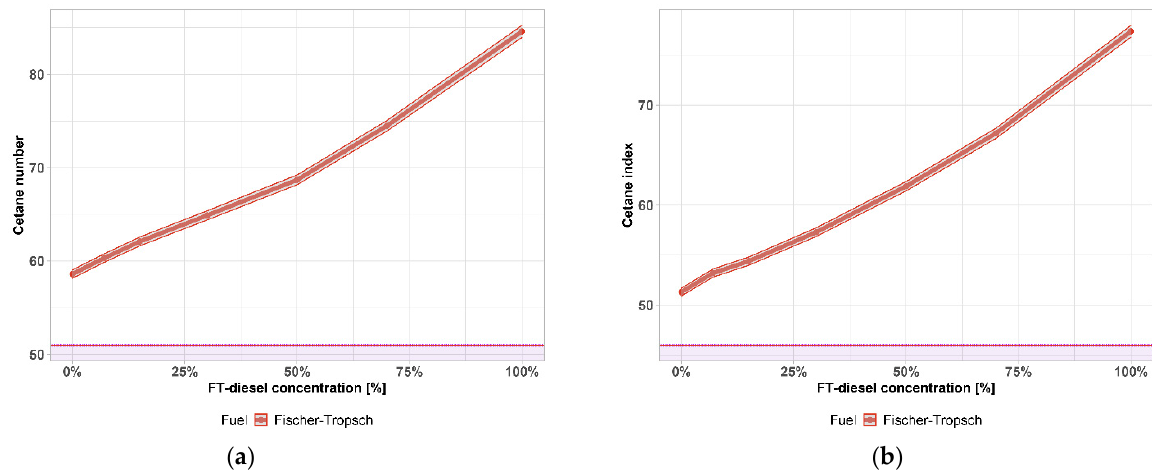
Figure 2. ( a ) Cetane number of FT-diesel mixtures; ( b ) cetane index of FT-diesel mixtures. The minimum limit of the cetane number for a cold start is 40 units, for an easy cold